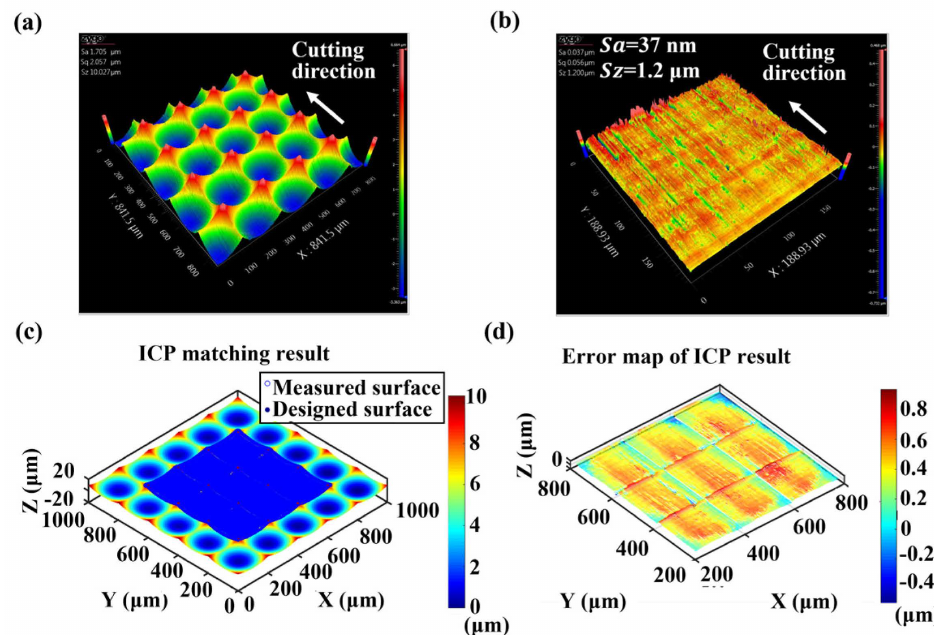
Figure 12. An analysis of surface quality and form accuracy of the microlens array machined by CS: ( a ) Measured 3D structure, ( b ) surface morphology of a single lenslet after removing the 3D form, ( c ) ICP match result of the measured structure and the designed structure; ( d ) error map obtained from the ICP result.